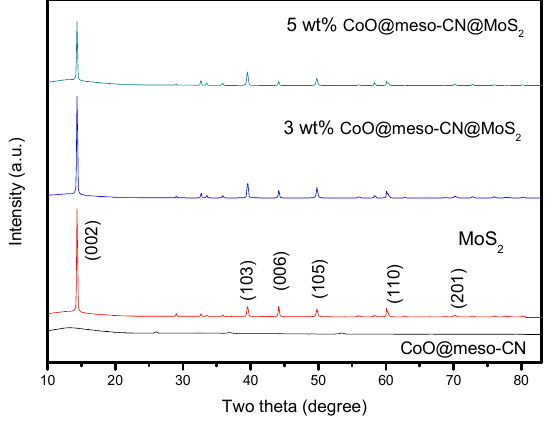
Figure 2. XRD profiles of heterojunction photocatalysts.